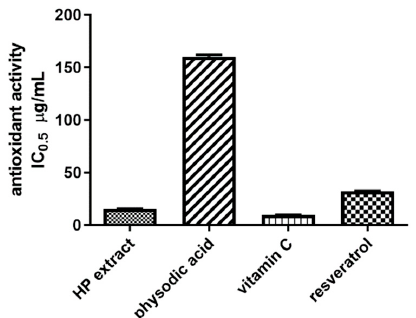
Figure 5. Antioxidant activity of H. physodes extract (HP extract), physodic acid, and the reference substances: resveratrol and vitamin C, measured in CUPRAC experiment. Results are presented as IC 0.5 values ( μ g/mL) as the mean value ± SEM, the average from n = 6 measurements was calculated.